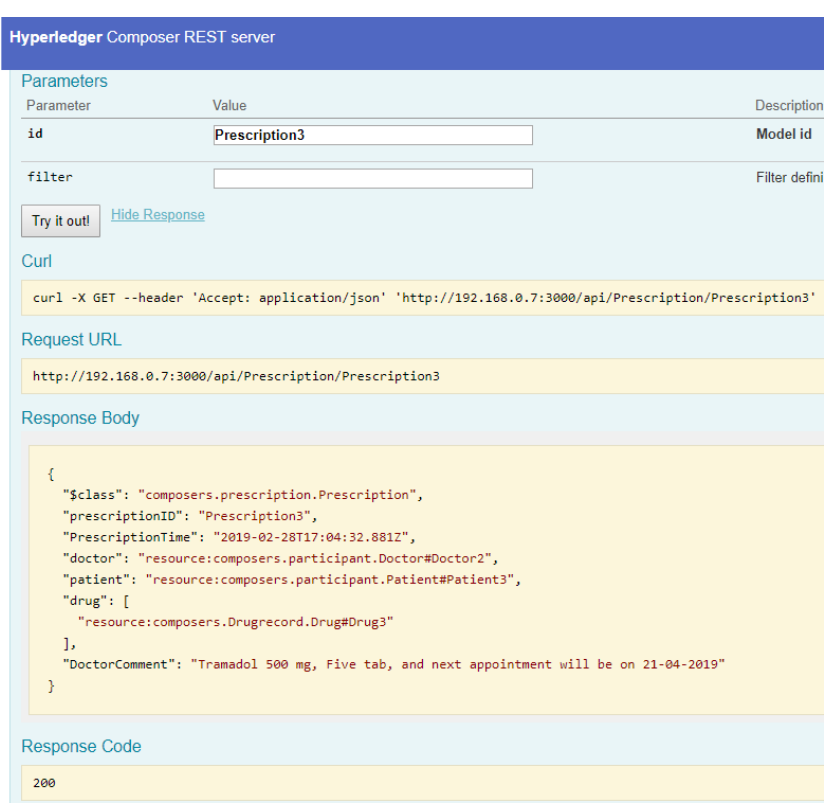
Figure 23. Fetching the prescription record through the Composer REST server.